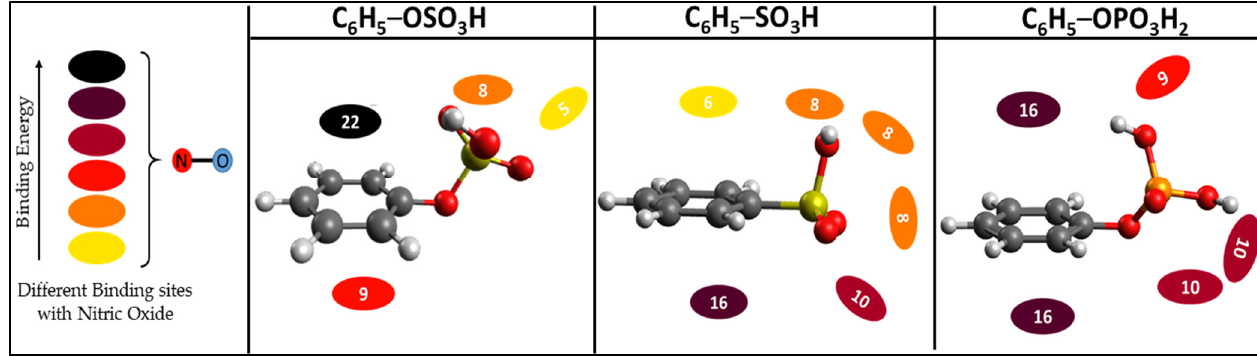
Figure 8. Schematic representation of the different binding sites of the three top-performing functional groups (–OSO 3 H, –SO 3 H, –OPO 3 H 2 ). The numbers in the oval shapes are the corresponding binding energies in kJ/mol calculated at the RI-DSD-BLYP/def2-TZVPP level of theory (without BSSE correction).